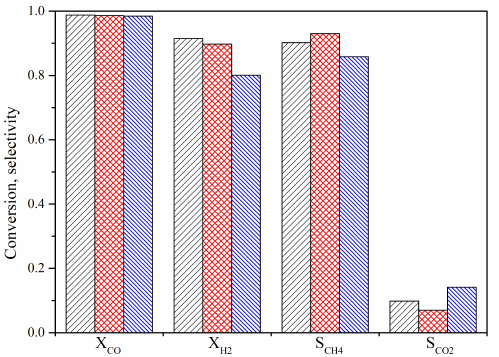
Figure 14. Conversion rate and selectivity under different configuration. Black column: normal arrangement of tubes. Red column: staggered arrangement of tubes. Blue column: without tubes.